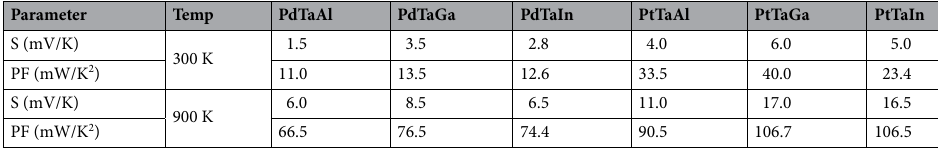
Table 2. Approximate values of Seebeck coefficient (S) and Powerfactor (PF) of XTaZ alloys calculated at 300 K and 900 K temperature range.